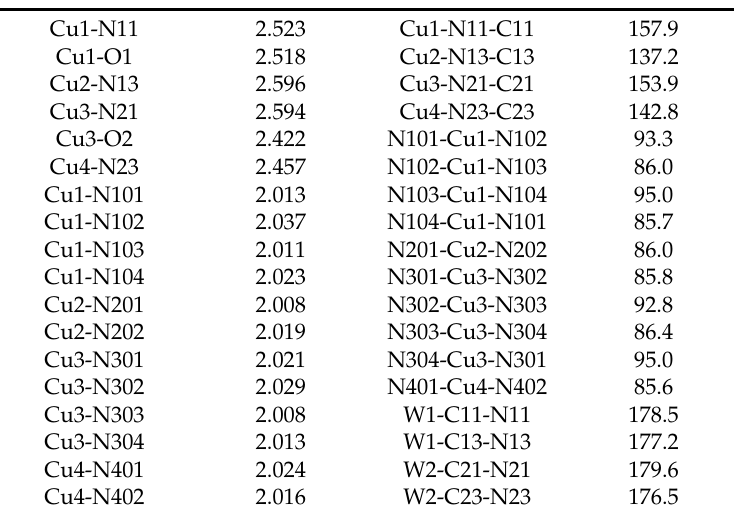
Figure 3. Structure of 2 · 3H2O with atom numbering; ellipsoids at 50% probability. Table 3. Selected bond lengths (Å) and angles (°) in 2·3H 2 O .